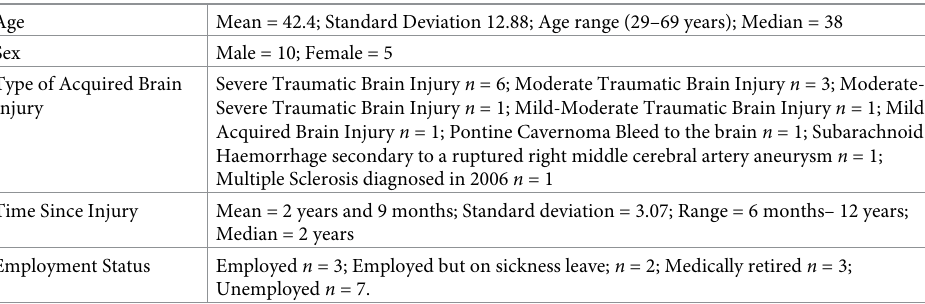
Table 1. Participant